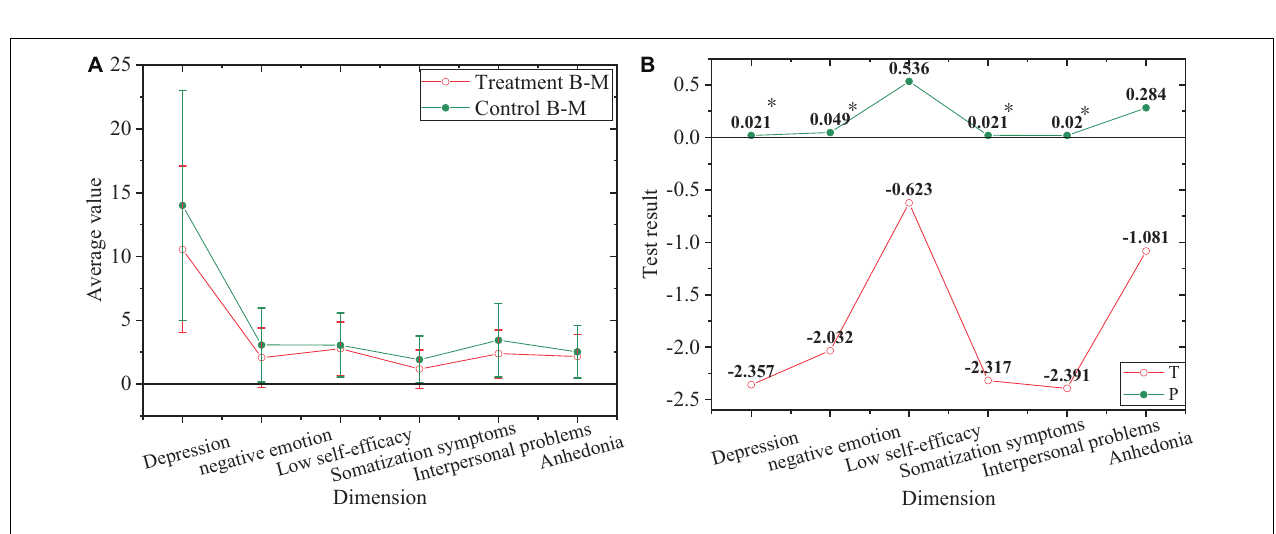
FIGURE 11 | Comparison of negative emotions. (A) Values of juniors after the experiment. (B) Value of T and P of juniors after the experiment. “ ∗ ”Means a significant difference, while “ ∗∗ ” shows a highly significant difference.